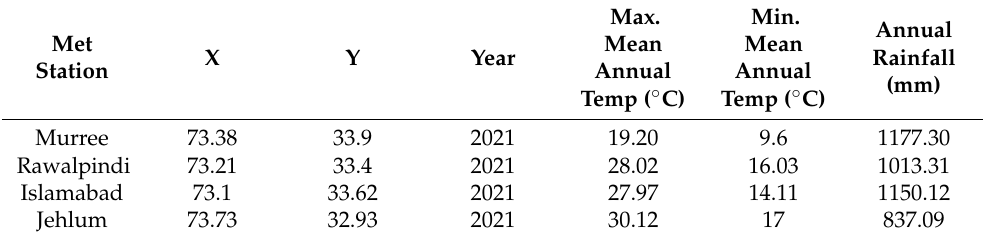
Table 8. Climatic data of four Met. Station for the year 2021.